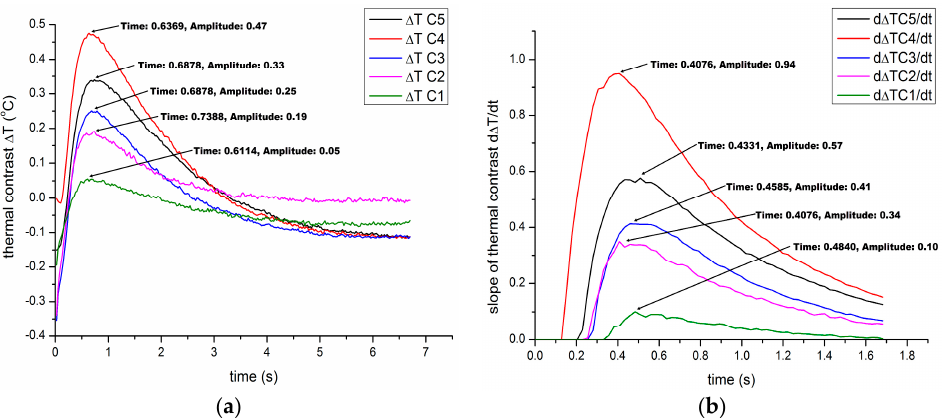
Figure 6. Temporal evolution of: ( a ) the thermal contrast curves; and ( b ) the correspondent slope of the thermal contrasts for the detected insertions on the trapezoid surface located to the depth of 0.6 mm (Series C).